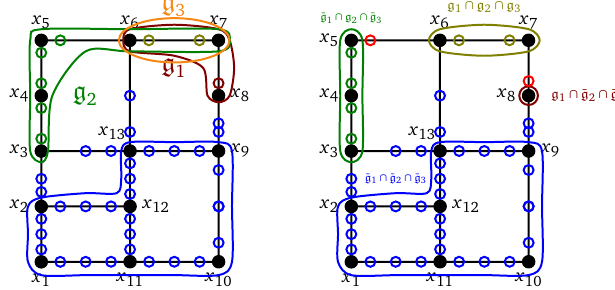
Figure 4: The intersection of the three facets identified by the subgraphs g This codimension-3 face has the same vertex structure as the intersection identified by the partially overlapping graphs g scattering facets S depicted by the markings , , and . The remaining vertices, denoted by and , respectively, identify the simplex Σ (cid:54)